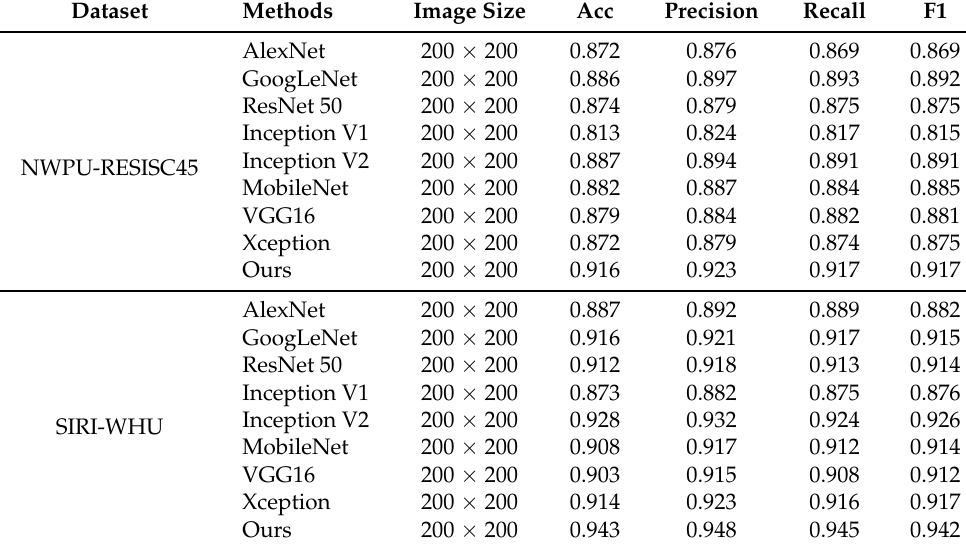
Table 1. The evaluation metrics results while using different deep learning models on NWPU- RESISC45 and